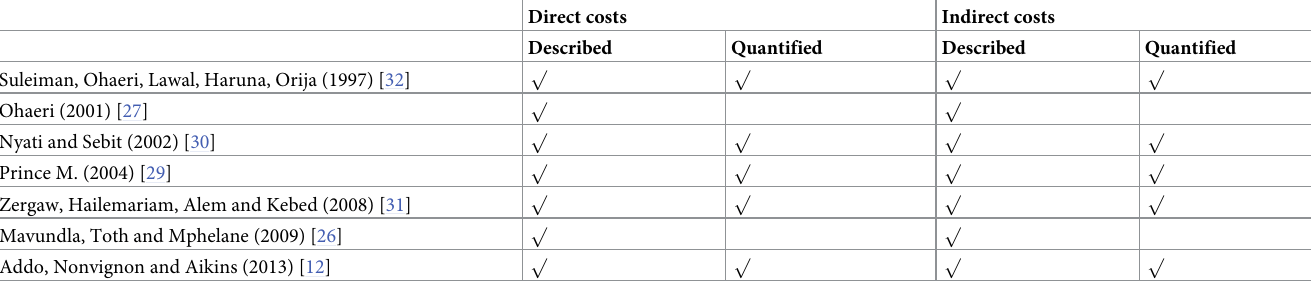
Table 2. Components of economic burden assessed and reported by reviewed